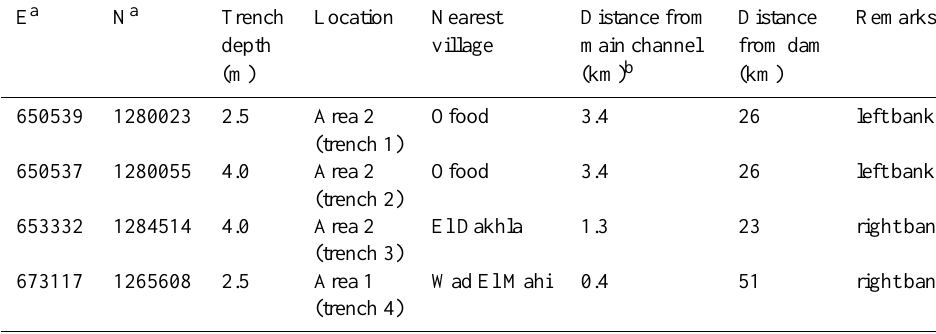
Table 3. Summary of the characteristics of the four trenches. E a